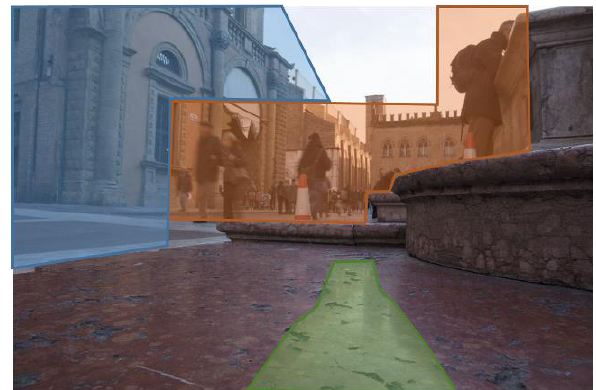
Figure 6. Image of the North-East corner of the fountain. Examples of problematic areas are highlighted: light reflections (green), changing of the background for people presence (orange) and out of focus objects (blue).